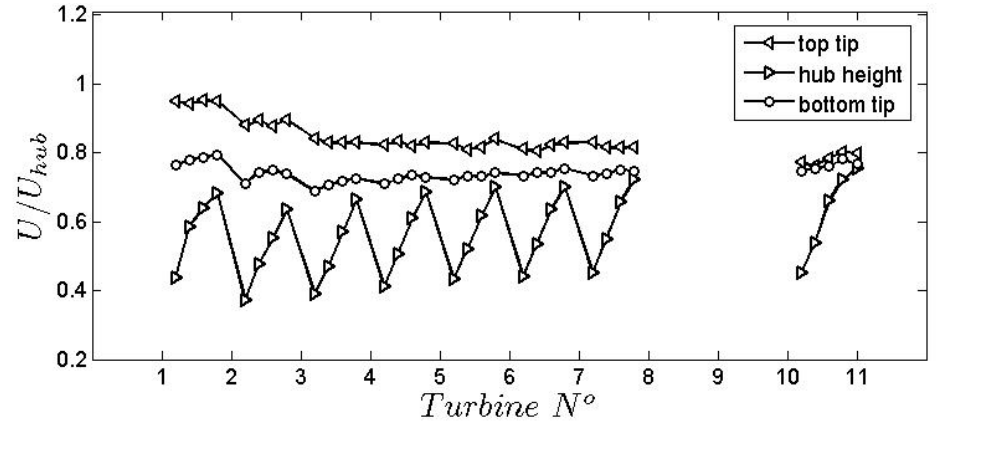
Figure 5. Normalized streamwise velocity component distribution in the wind farm. S = 7 ( bottom ( top ) and S x